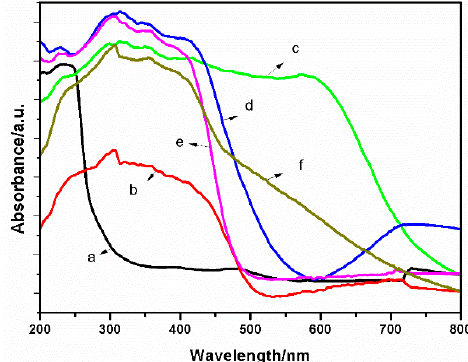
Figure 2. UV – Vis DRS spectra of ( a ) [Bmim]Br ionic liquid, and hybrid materials ( b ) [Bmim] 3 PMo 12 O 40 , ( c ) [Bmim] 5 PMo 11 Co(H 2 O)O 39 , ( d ) [Bmim] 5 PMo 11 Ni(H 2 O)O 39 , ( e ) [Bmim] 5 PMo 11 Zn(H 2 O)O 39 , ( f ) [Bmim] 5 PMo 11 Mn(H 2 O)O 39 .